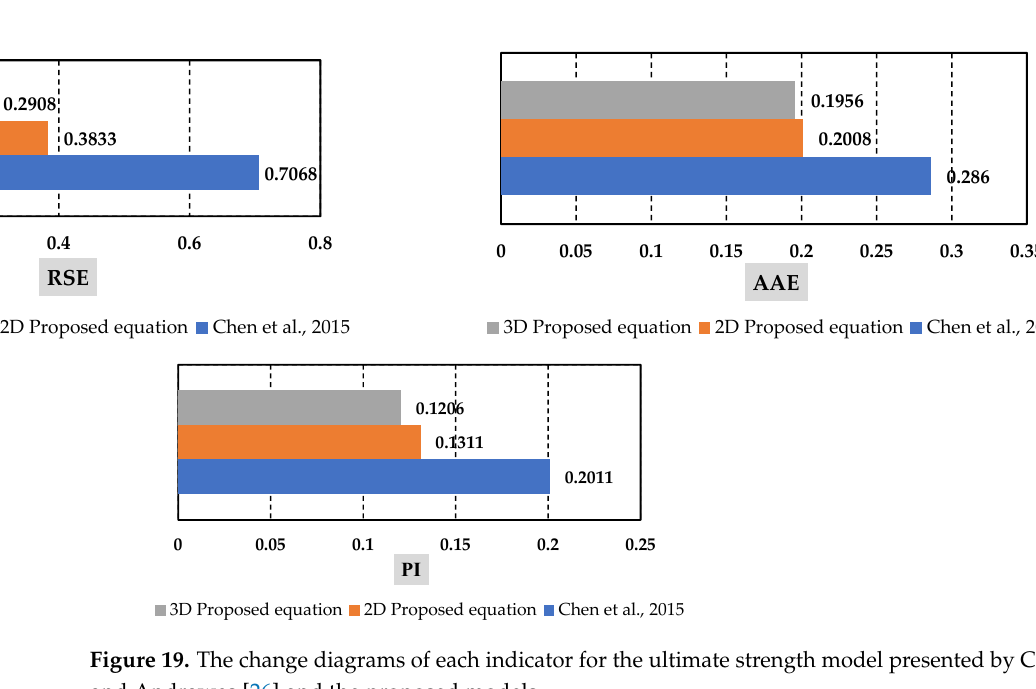
Table 16. Statistical indicators of ultimate strain models of SMA confined concrete.